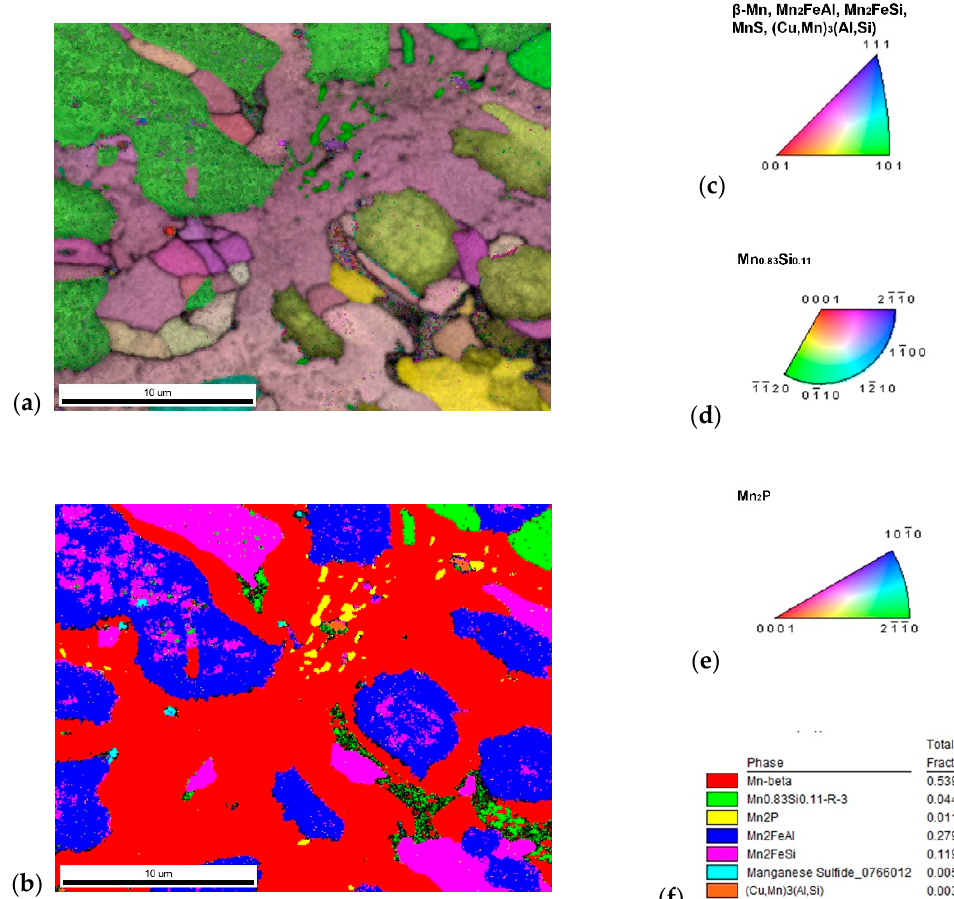
Figure 5. The sample with 10% excess of aluminum ( a ) inverse pole figure (IPF) map overlayed on a greyscale Image Quality map; ( b ) phase distribution overlayed on a greyscale Confidence Index map, whose color code and percentage of area coverage are given in ( f ). Colorized legend of particular phases are in ( c – e ).